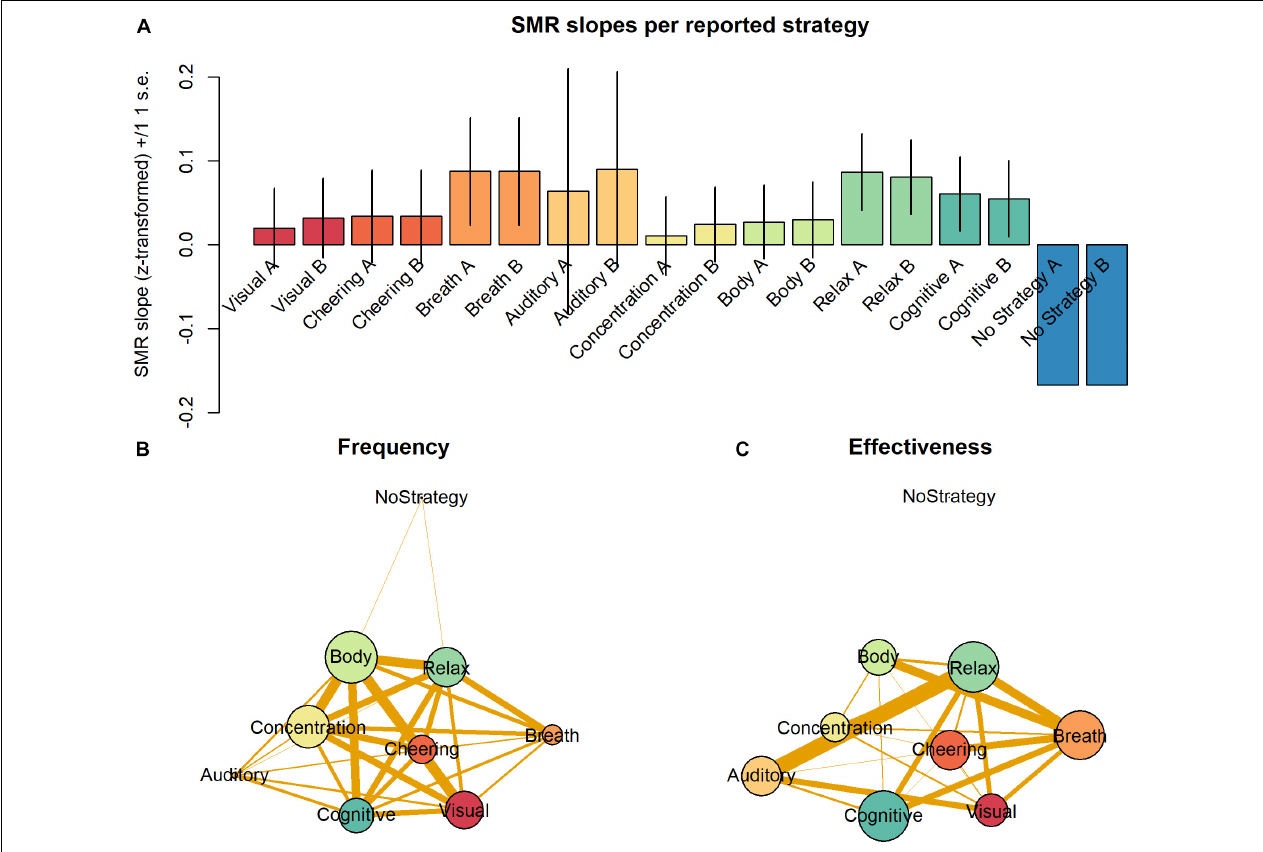
FIGURE 4 | (A) Average SMR slopes are depicted for each one of the nine strategies as categorized by the two raters. (B) Frequency of occurrence of the nine different strategies is depicted by the vertex size. Edge thickness represents the probability of co-occurrence of the strategies. (C) Effectiveness of the nine different strategies as defined by the proportion of responders is depicted by the vertex size. Edge thickness represents the probability of co-occurrence of the strategies. Other parameters of the graphs (B) and (C) were arbitrarily defined for display purposes only.